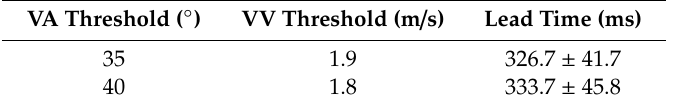
Figure 6. Accuracy determined using VA and VV thresholds. Table 4. Lead times according to threshold combinations. Table 4. Lead times according to threshold combinations.